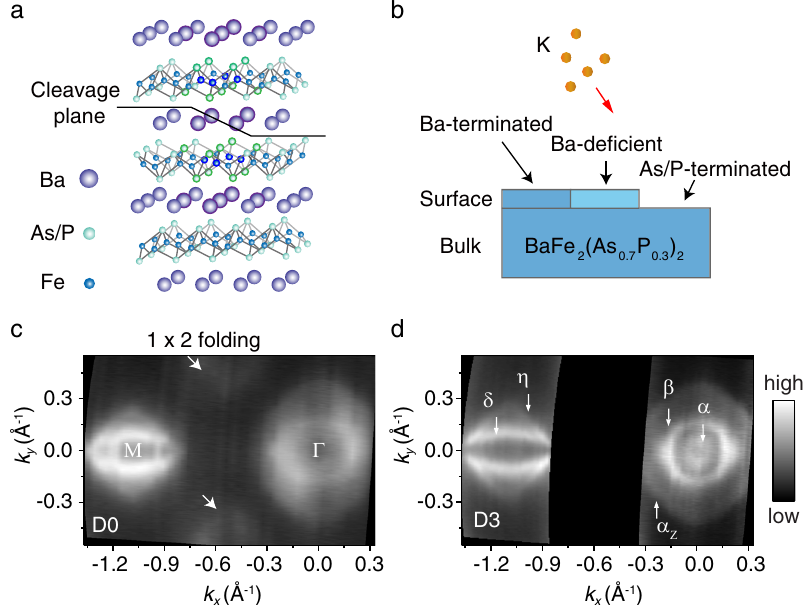
Fig. 1 Surface complexity of BaFe 2 (As 0.7 P 0.3 ) 2 . a Schematic drawing of the lattice structure of BaFe 2 (As 0.7 P 0.3 ) 2 . The black solid line illustrates the position of a possible cleavage plane. b Schematic drawing of the cleavage surface and potassium deposition. c Fermi surface mapping taken in the pristine sample (D0). k x and k y are the momenta of electrons along x and y directions. Panel d is the same as c but taken in the doped sample (D3) after three times potassium